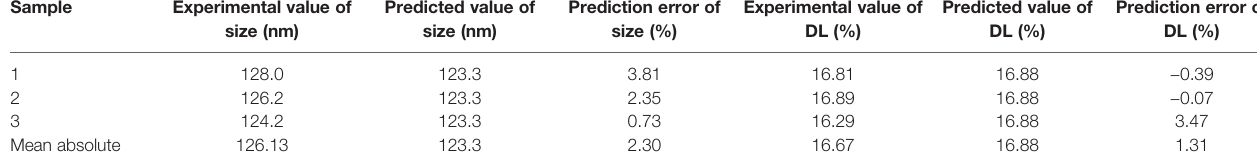
TABLE 7 | Comparison of predicted and experimental value (n = 3).